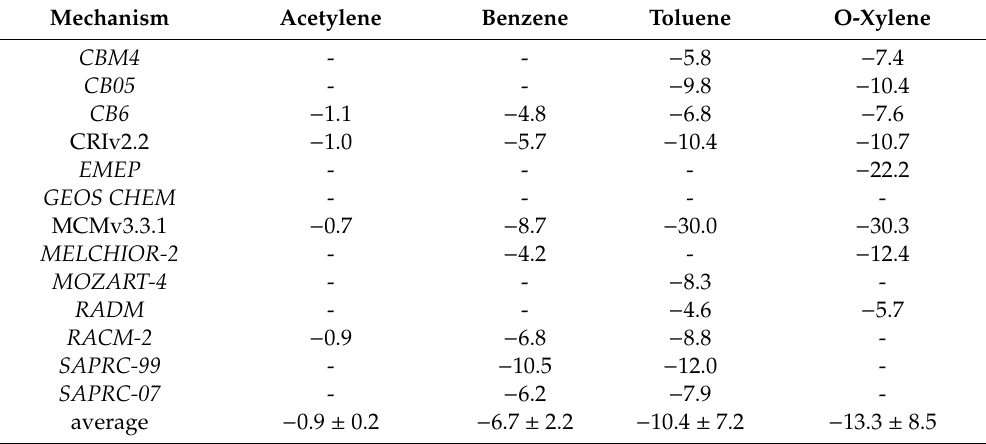
Table 6. Initial a hydroxyl radical incremental reactivities for acetylene and the aromatics in units of 10 6 molecule cm − 3 per ppb hour − 1